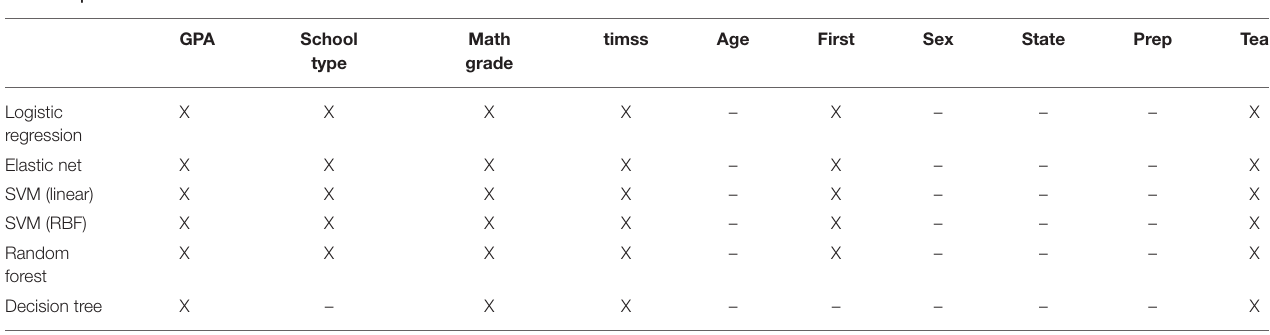
TABLE 6 | Selected features for the different methods.